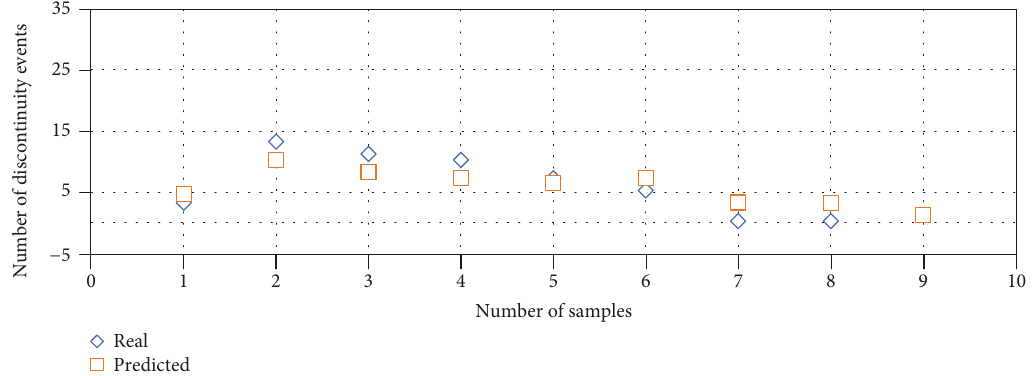
Figure 2: Comparison of the forecast and actual number of discontinuity